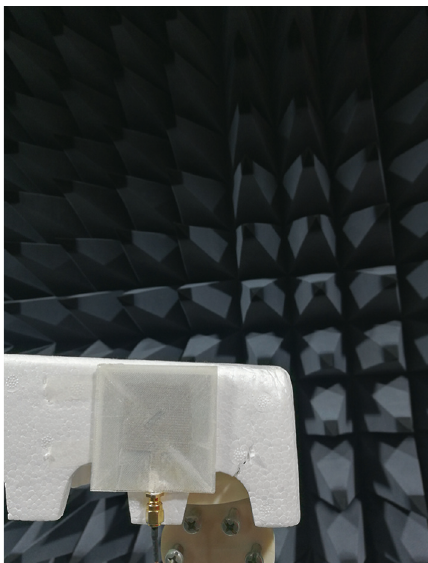
Figure 7: The measurement in the chamber.